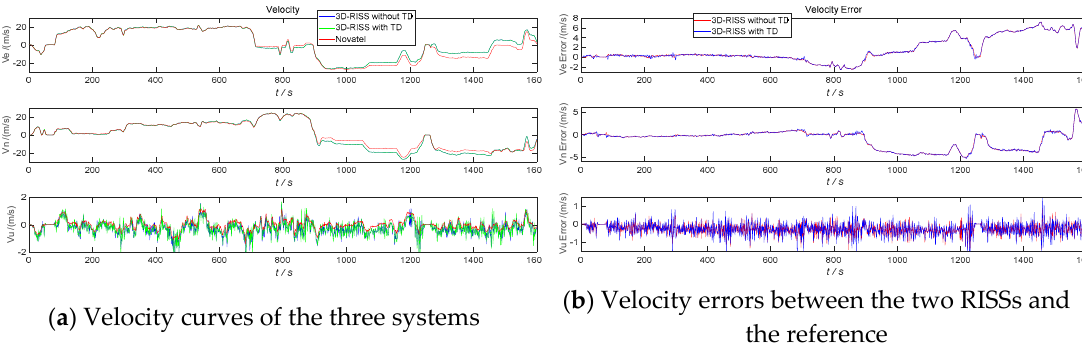
Figure 6. RISS velocity and velocity errors with the original odometer velocity filtered by TD.